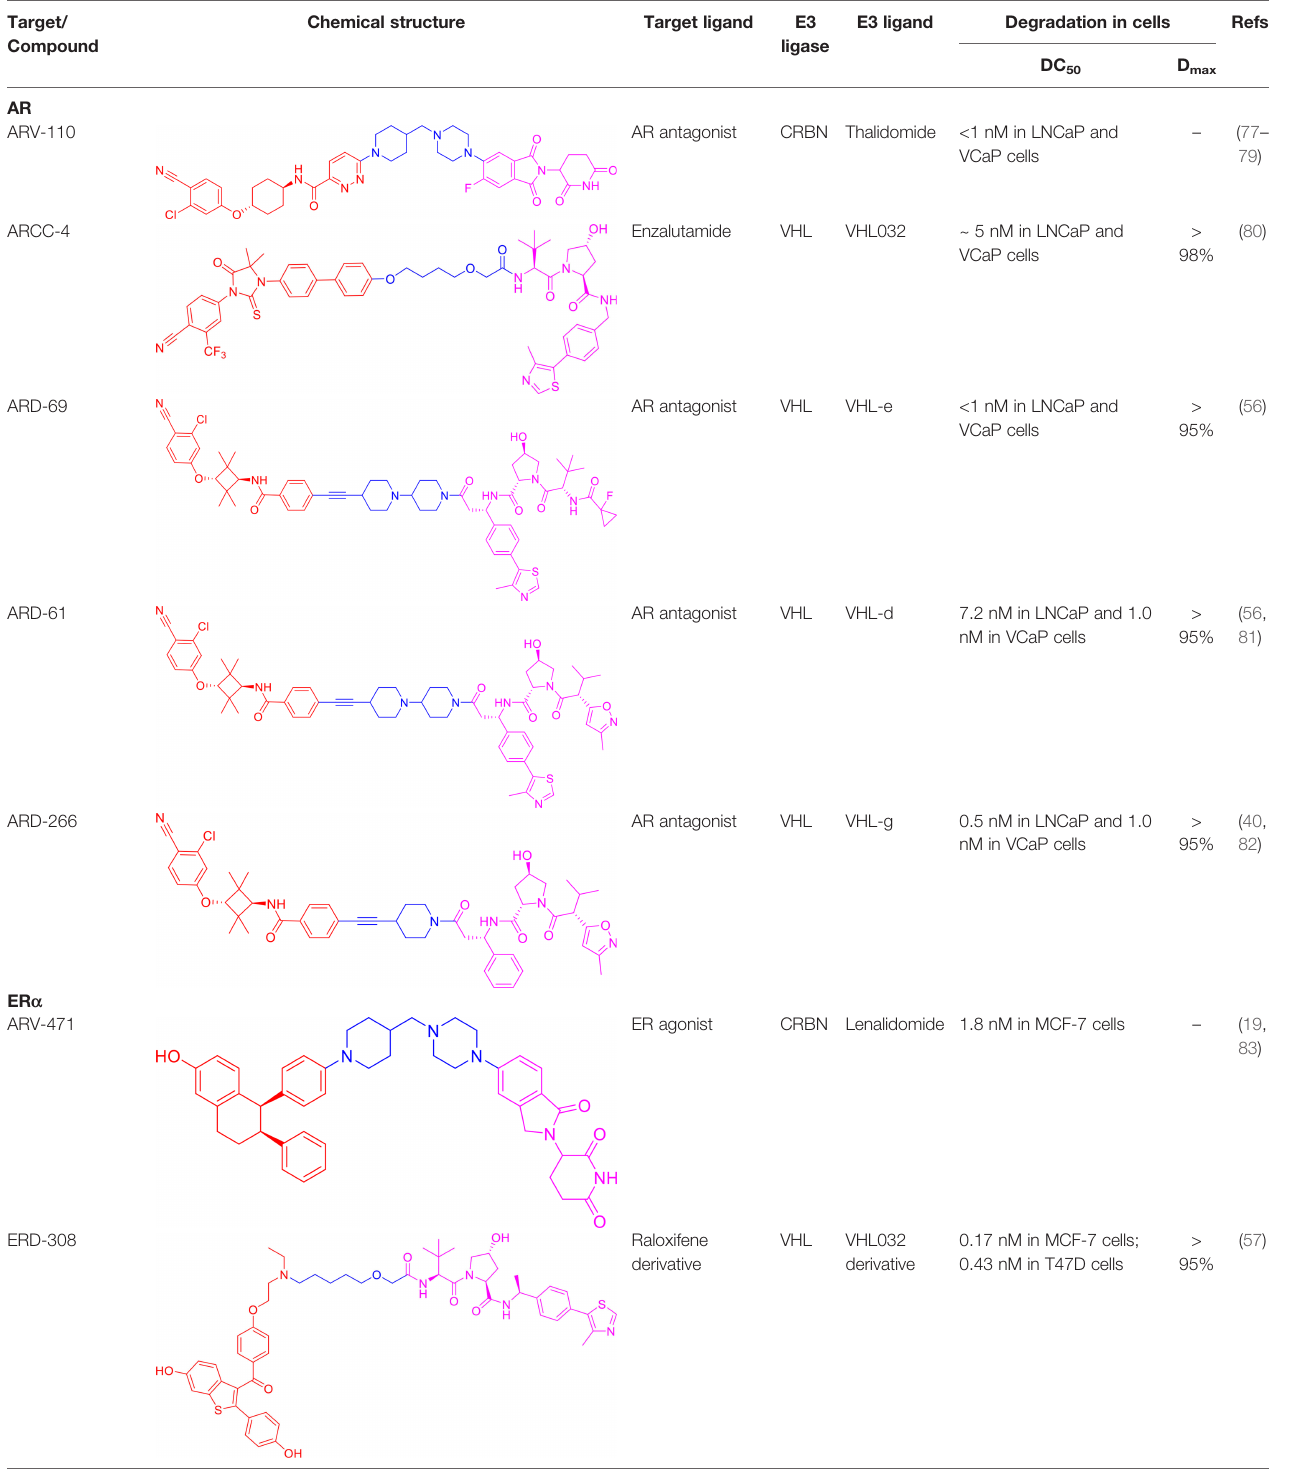
TABLE 1 | Components and properties of small-molecule PROTACs in sex hormone-dependent